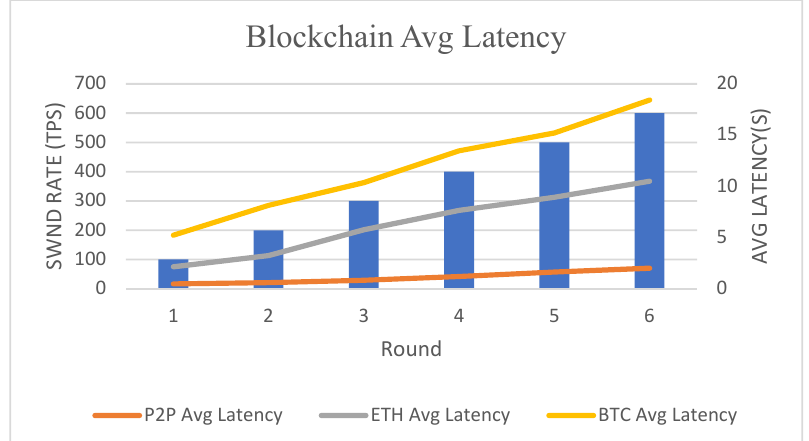
Figure 46. Transaction delay comparison of three architectures.